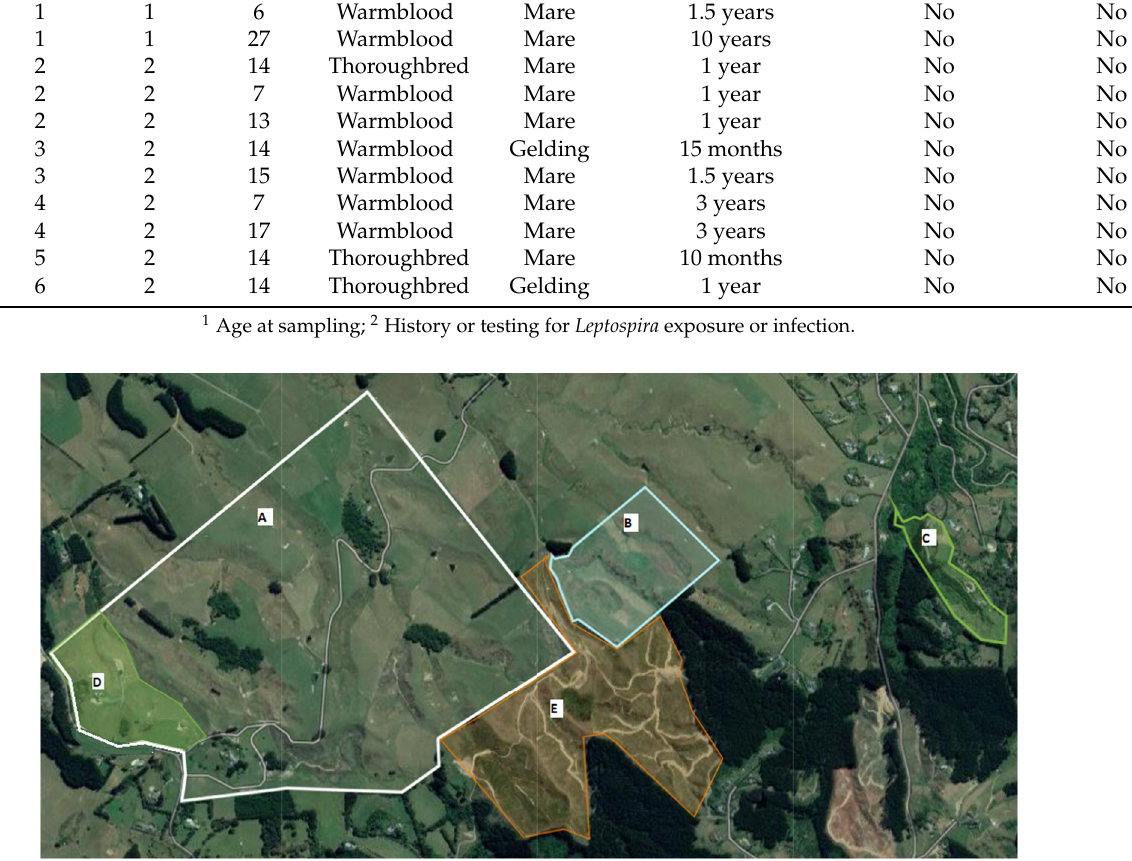
Figure 1. Satellite map showing the location of the two farms where a group of horses were blood sampled as part of testing for leptospiral antibodies after a leptospirosis outbreak in alpacas. Location of Farm 1 containing alpaca and horses ( C ), Farm 2 ( A ) and grazing location of horses on Farm 2 ( D ), land where alpaca were located part of the year ( B ) and access to riding trails for horses ( E ). Results of the farm survey are shown in Table 2. Neither property had a natural water source or history of flooding; stock drinking water was either rain water collected into tanks (Farm 1) or bore water (Farm 2), pumped to troughs. Farm 2 reported no signs of wildlife on the property apart from rabbits. Both farms had cats, dogs and sheep on the property, with Farm 2 also having beef cattle. No animals on Farm 2 were reported as being vaccinated for leptospirosis, whilst the dogs on Farm 1 were vaccinated. On Farm 1, horses were grazed alternately, had contact over the fence and shared the same water source